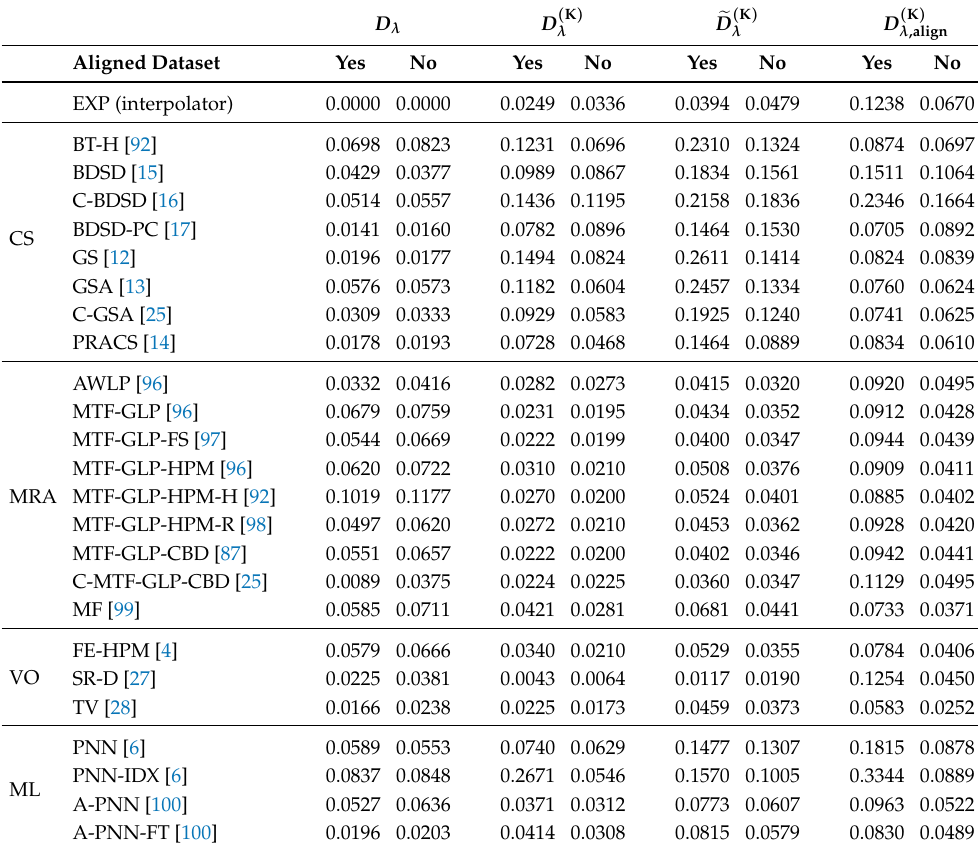
Table 2. Misregistration impact on D λ , D ( K ) methods can be found in